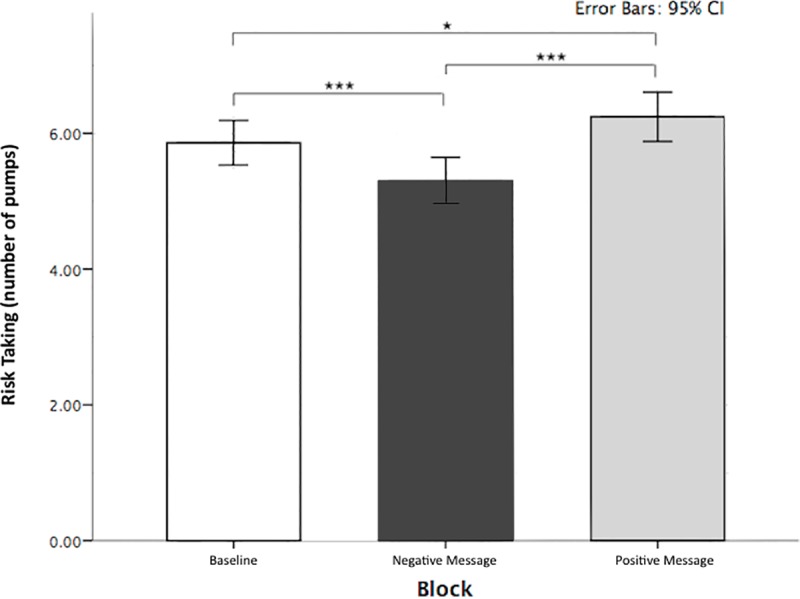
Risk taking in the BART task as a function of number of inflations in each experimental block.Note: The dashed line represents performance in the baseline; error bars show 95% confidence intervals; asterisks indicate significance values (*p < .05, **p < .005, ***p < .001).